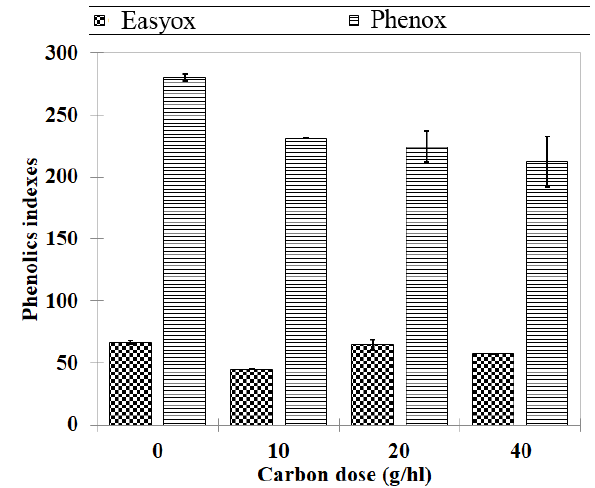
Figure 5. Effect of fining with carbon on the composition of Pinot gris must. Figure 5. E ff ect of fining with carbon on the composition of Pinot gris